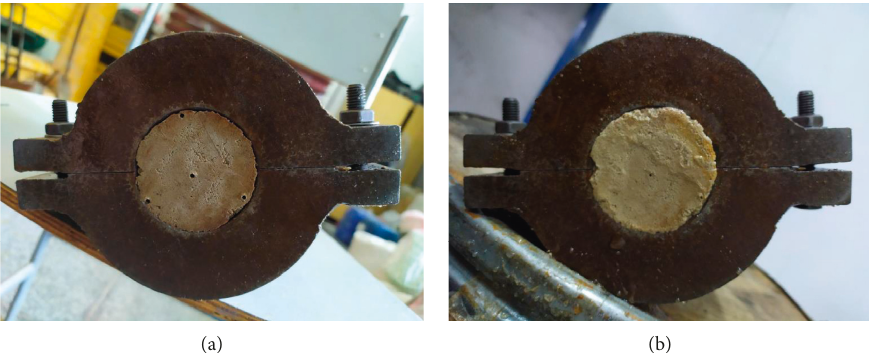
Figure 8: One comparison of the initial cracks and reclosed cracks: (a) initial cracks of experiment No.10; (b) cracks reclosed of experiment No. 10.